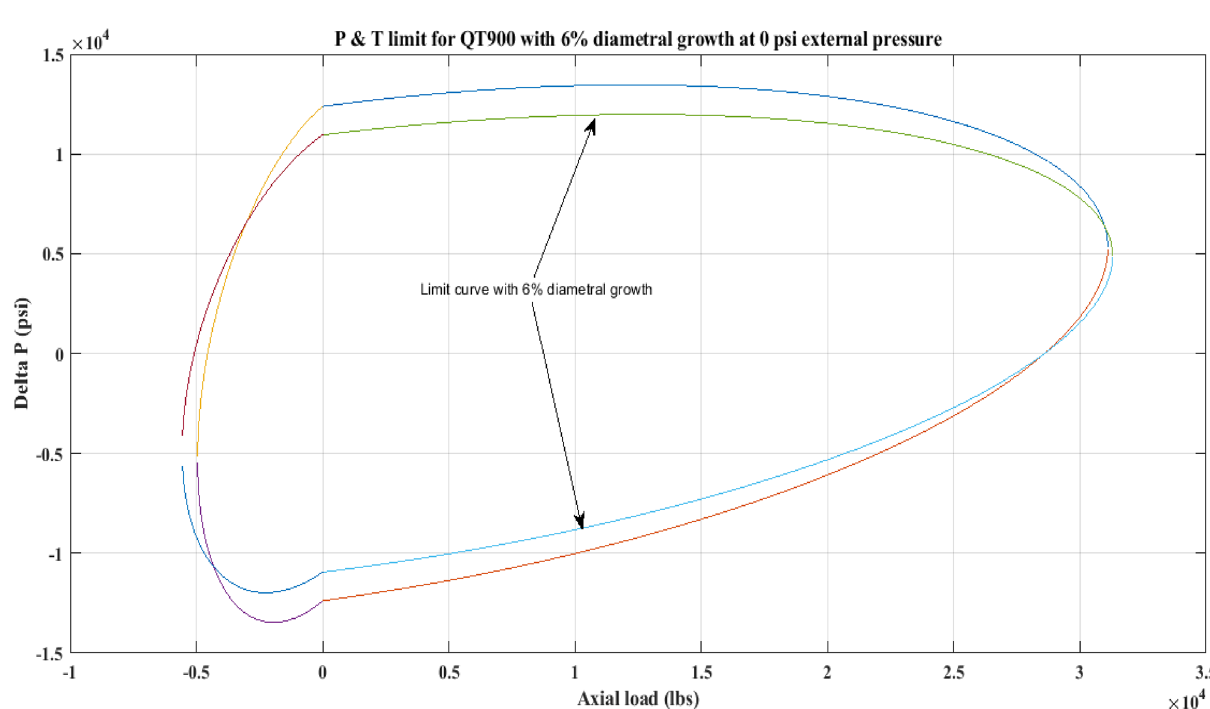
Figure 10. P and T limit with diameter growth for QT 900 at 0 P o